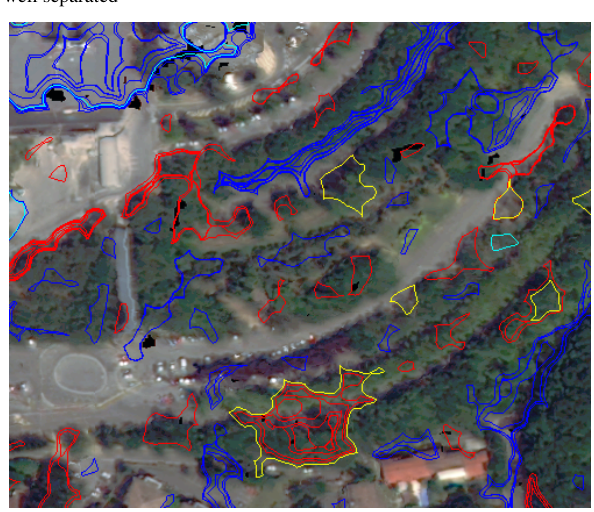
(b) On the vegetation: most complex components are filtered out. Only the components with compact shapes remain and will need a vegetation mask to be filtered out. Figure 4: Result of the greedy search: all potential changes are encircled in red (destructions) and blue (constructions), selected changes are in yellow (destructions) and cyan (constructions).